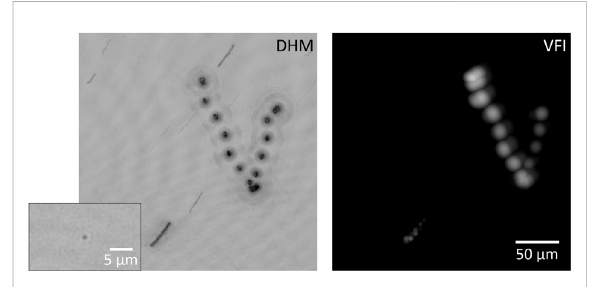
FIGURE 4 Correlative images of a eukaryotic cell expressing native fl uorescence captured by DHM amplitude and VFI intensity. The images are captured over 4 s (60 frames) and volume reconstructed. The DHM amplitude reconstructions are minimum projected inthez-direction and then overlaid over time. The VFI intensity reconstructions are maximum projected in the z-directionandthenoverlaidovertime.(Inset)1 µmbacteria-sized object detected byDHM. The image wasobtained from oneframe of a series of images showing the bacterial